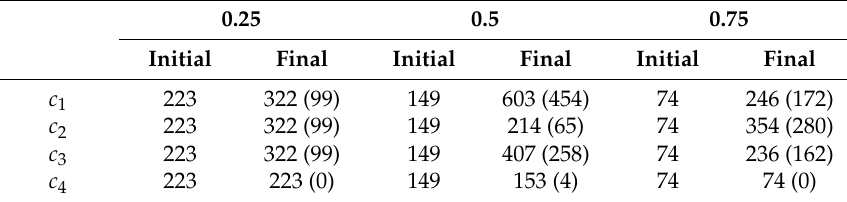
Table 10. Amount of samples in each c i of M-training with different unlabeled rates.